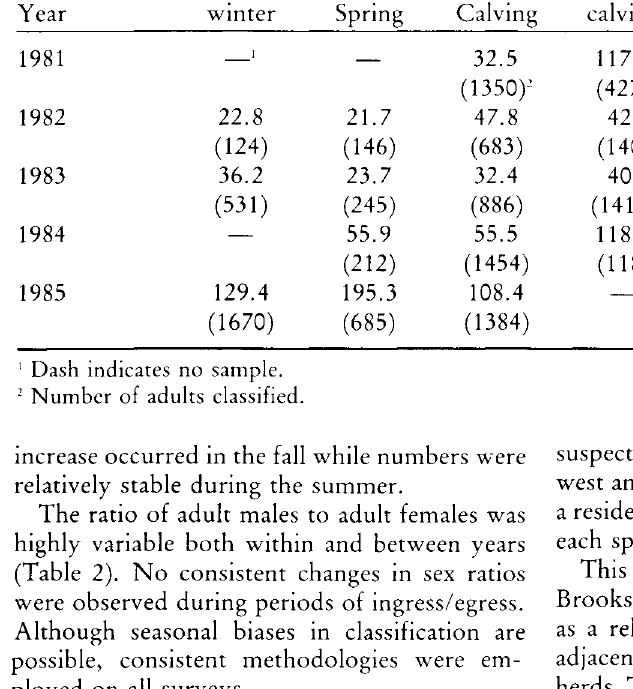
Table 2. Ratio of adult males: 100 females in various seasons from 1981 to 1985.